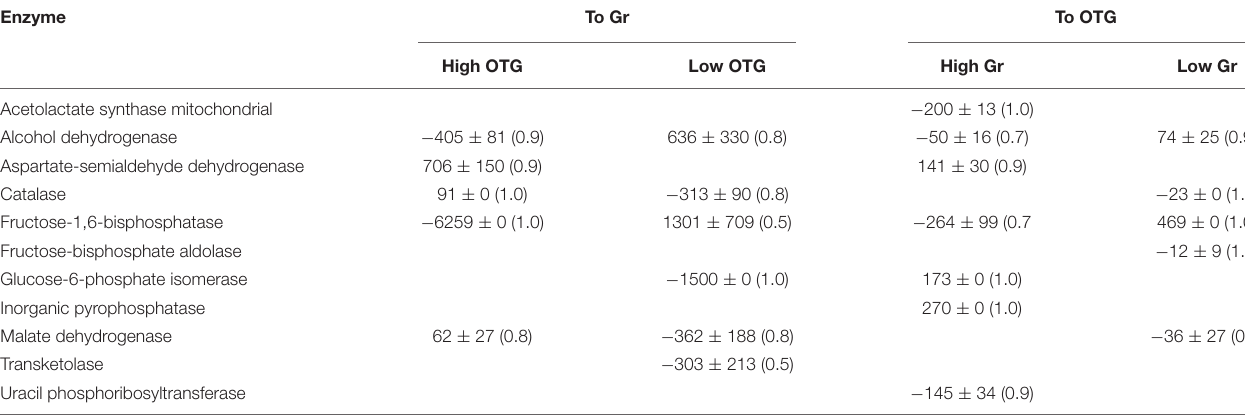
TABLE 4 | Correlation between calculated active-site volumes in enzymes and optimal temperatures for growth and growth rates of Antarctic